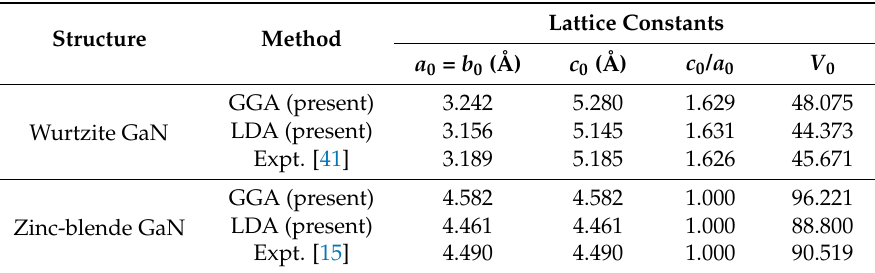
Table 1. Lattice constants of GaN